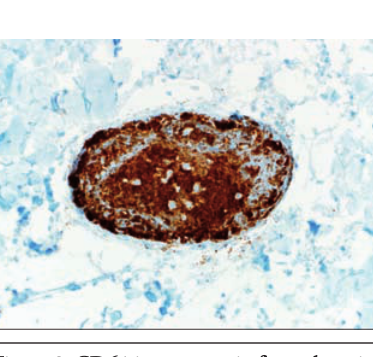
Figure 10. CD61 immunostain of the lower extremity lesion shows platelet microthrombus (IHC stain for CD61, 250 ¥